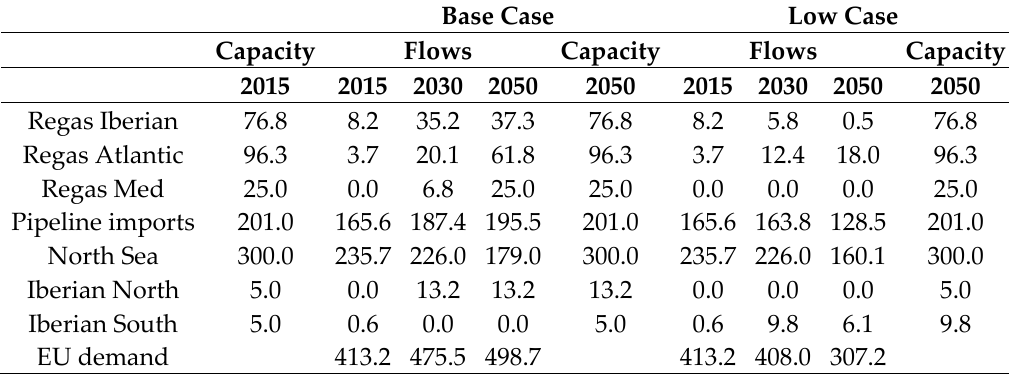
Table 1. EU gateway flows 2015–2050—low case (in